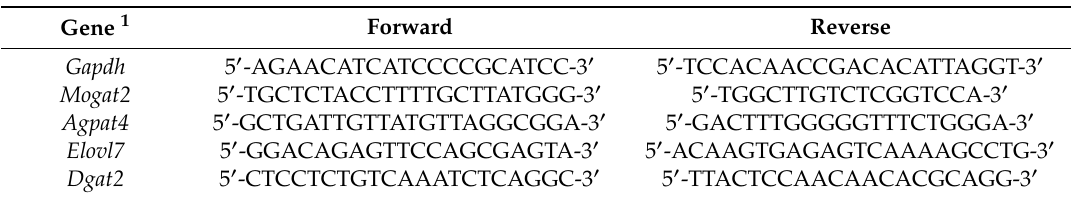
Table 1. qRT-PCR primer